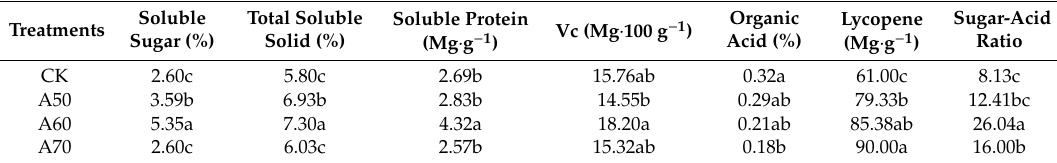
Table 3. Fruit quality under ADI.